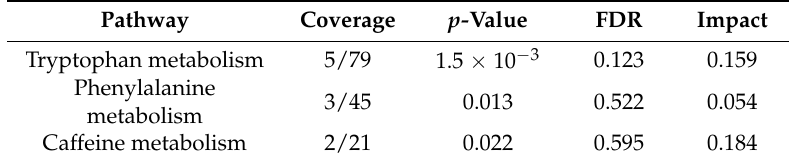
Table 5. Results from the pathway analysis based on the altered metabolites in SPMS patients compared with